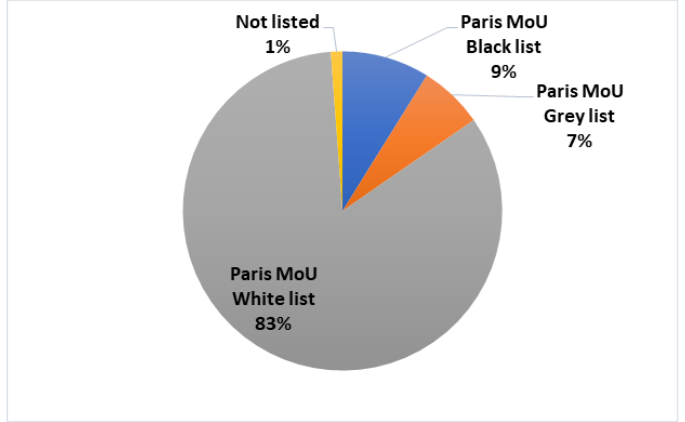
Figure A8. Frequency of BW discharging ships by ship flag.